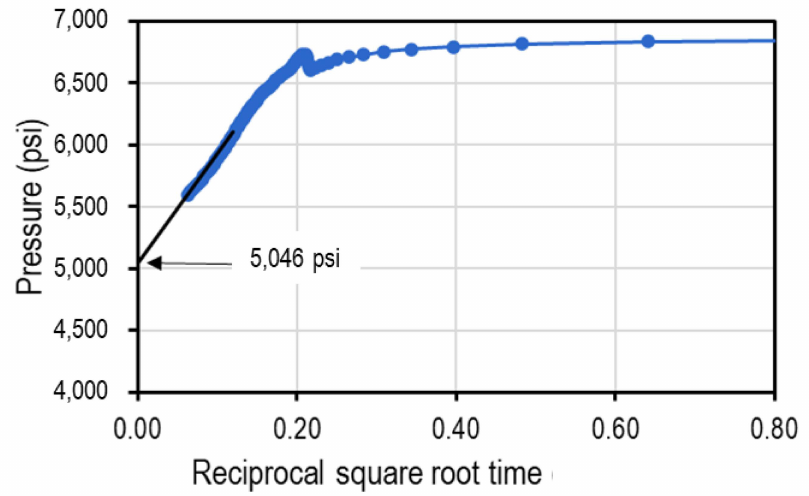
Figure 7. Post-closure reciprocal square root time for estimating pore pressure from a nearby well in the